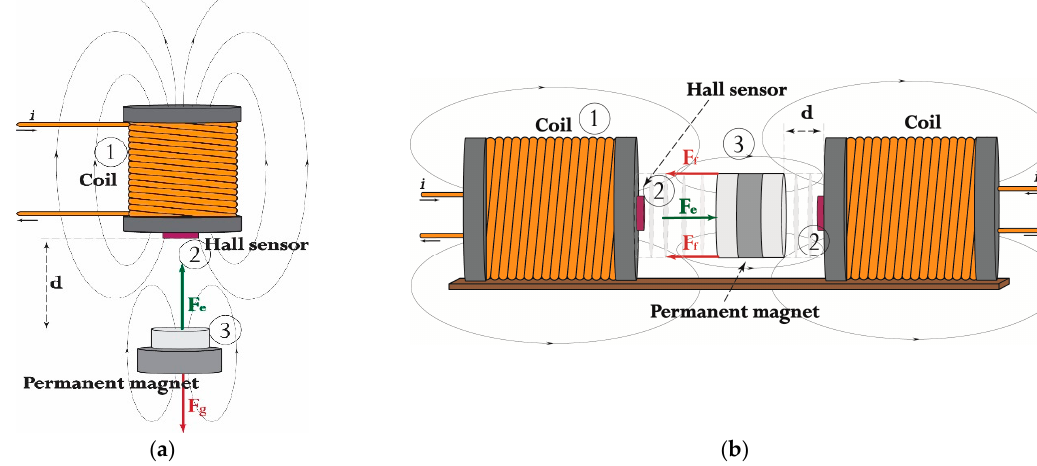
Figure 1. Two electromagnetic actuators with integrated proximity HE sensor-EMAwS; ( a ) Vertical movement of the body and ( b ) Horizontal movement of the body.